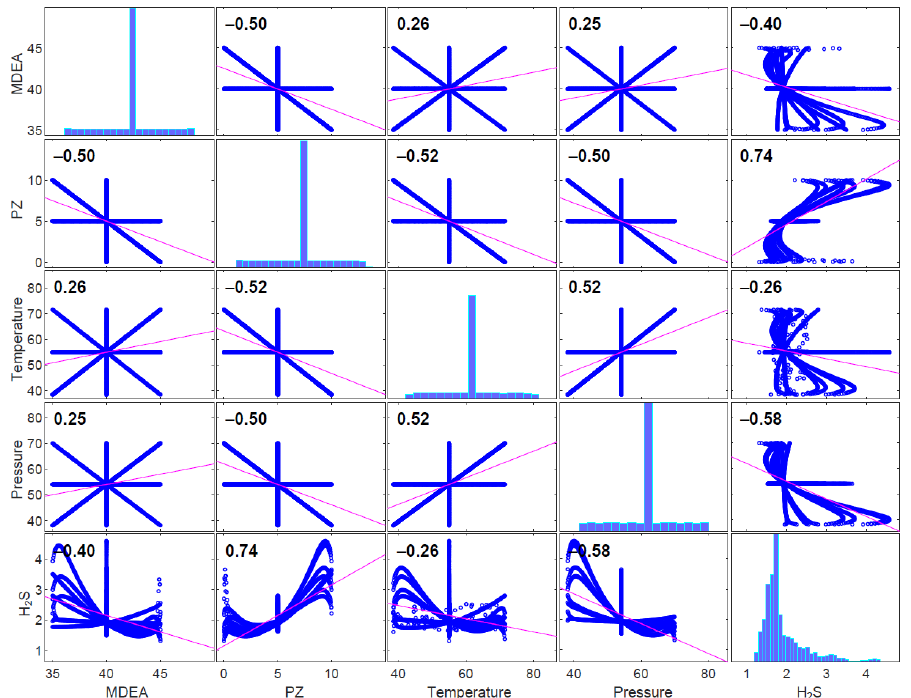
Figure 6. Scatter plots of concentration of H 2 S in sweet gas versus four parameters: MDEA (M), Piperazine (PZ), temperature (T) and pressure (P).